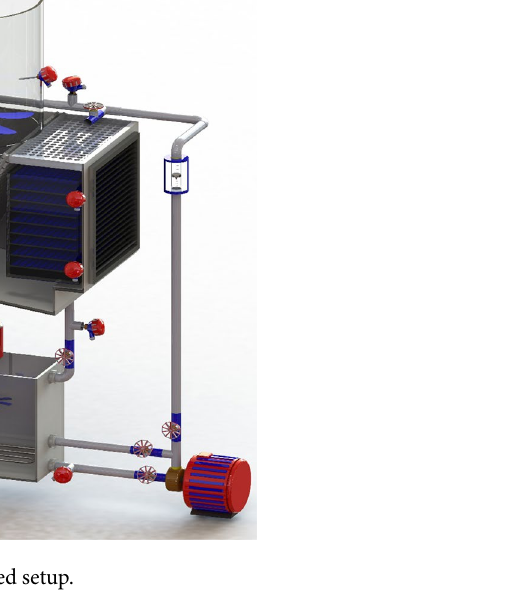
Figure 1. Schematic of the designed